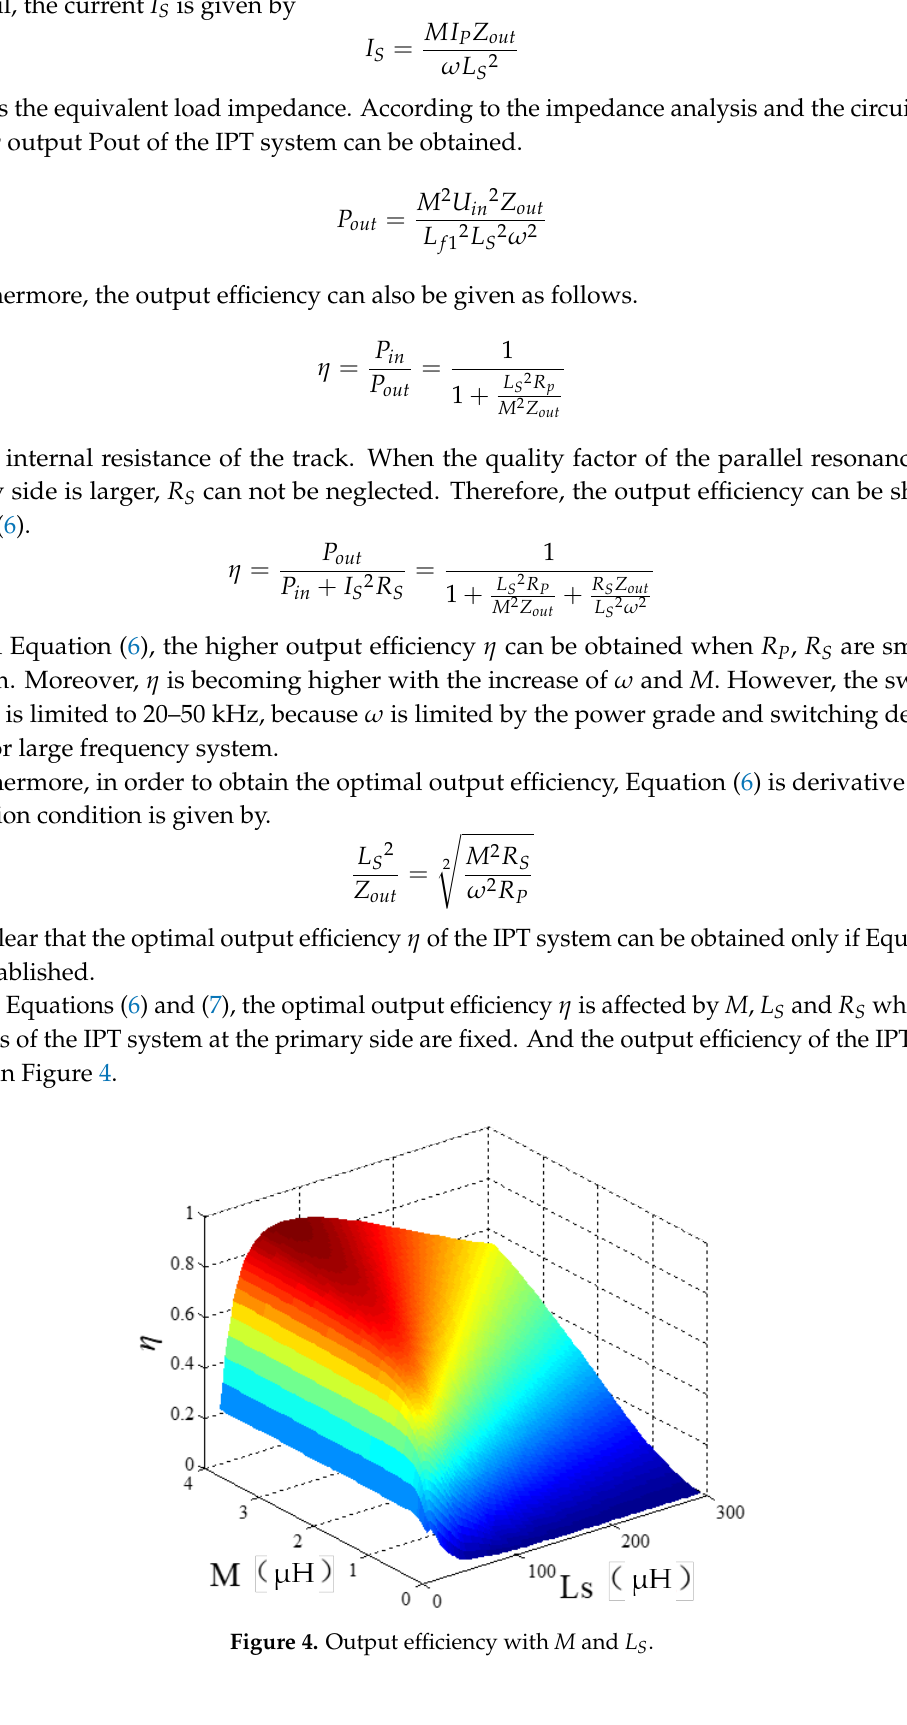
I p Figure 5. Magnetic field coupling model for RGV application. 3.1. Calculation of Self-Inductance Figure 6 shows the equivalent plane diagram of the coil and the track. Magnetic flux density B ( x,y ) at any point of the rectangular coil can be given by applying Biot–Savart law.